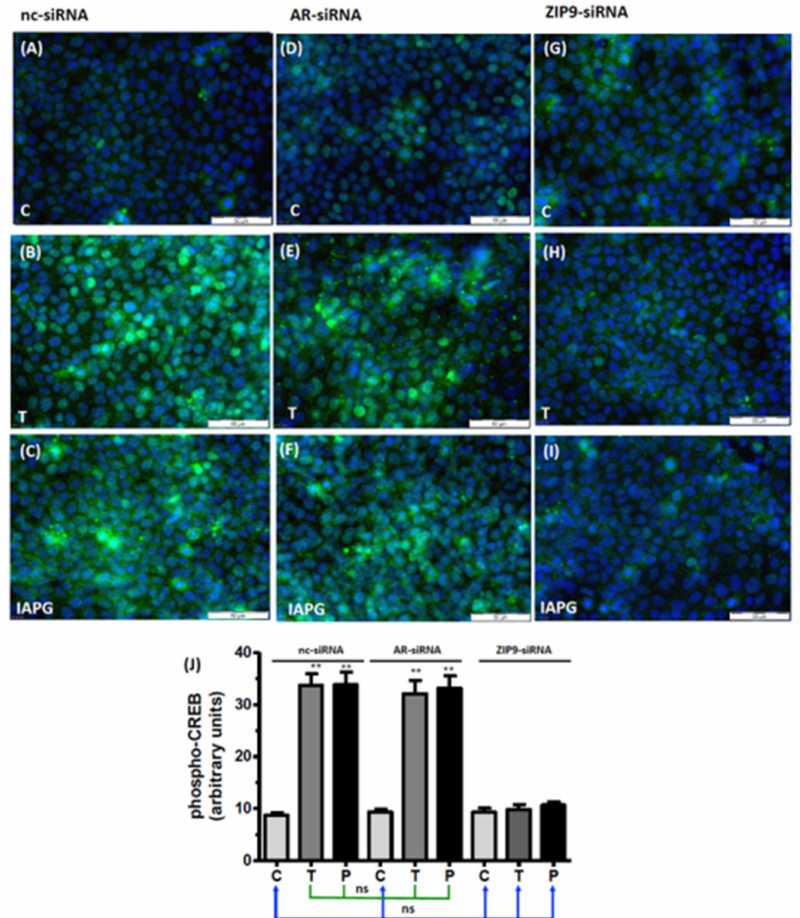
Figure 7. Immunofluorescence of p-CREB/p-ATF-1. Incubation with vehicle (C), 10 nM testosterone (T), or 10 µ M IAPG (P) was carried out for 24 h. Nuclei are stained blue and p-CREB/ATF-1 is green. ( A – C ) p-CREB/p-ATF-1 in cells treated with nc-siRNA. ( D – F ) p-CREB/p-ATF-1 in cells treated with AR-siRNA. ( G – I ) p-CREB/p-ATF-1 in cells treated with ZIP9-siRNA. ( J ) Statistical analysis of green fluorescence ( n = 3 × 25; means ± SEM; ** p ≤ 0.01; ns = not